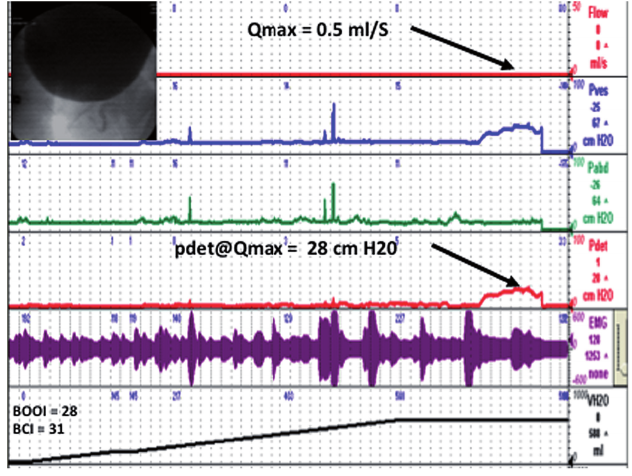
figure 2 - sample vuDs of patient with Du.